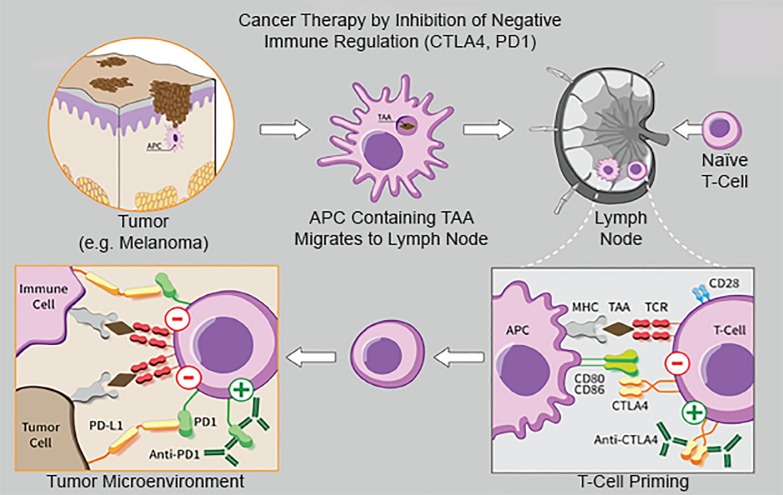
Checkpoint inhibitor mechanisms (CTLA-4 and PD-1).Modified from https://commons.wikimedia.org/wiki/File:11_Hegasy_CTLA4_PD1_Immuntherapie.png. Accessed April 7, 2019.CTLA4, cytotoxic T-lymphocyte antigen 4; PD-1, programmed cell death protein 1; PD-L1, programmed death-ligand 1; APC, antigen-presenting cell; TAA, tumor-associated antigen; TCR, t-cell receptor; CD, cluster of differentiation.